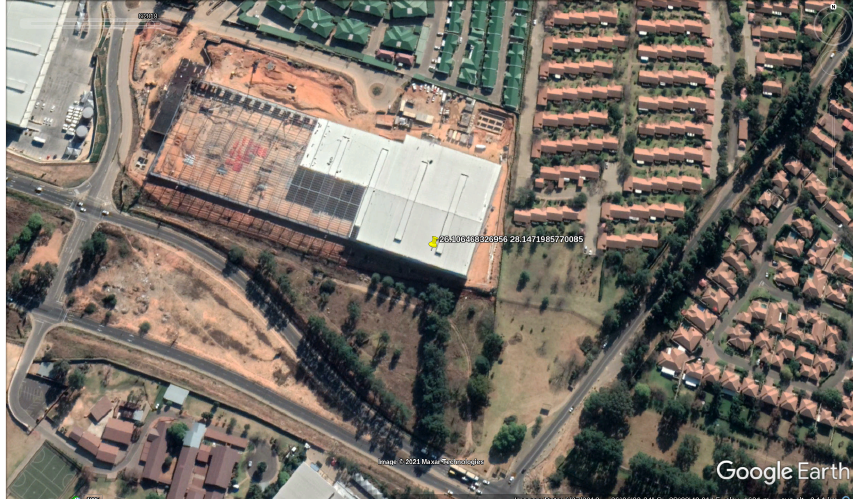
Figure 10. Google Earth image of a Thornhill Estates construction site.